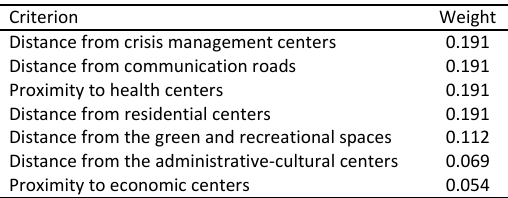
Table 4 ‐ Weights of urban elements and services Criteria for site selection of fire stations in District 12 of Tehran Based on AHP method